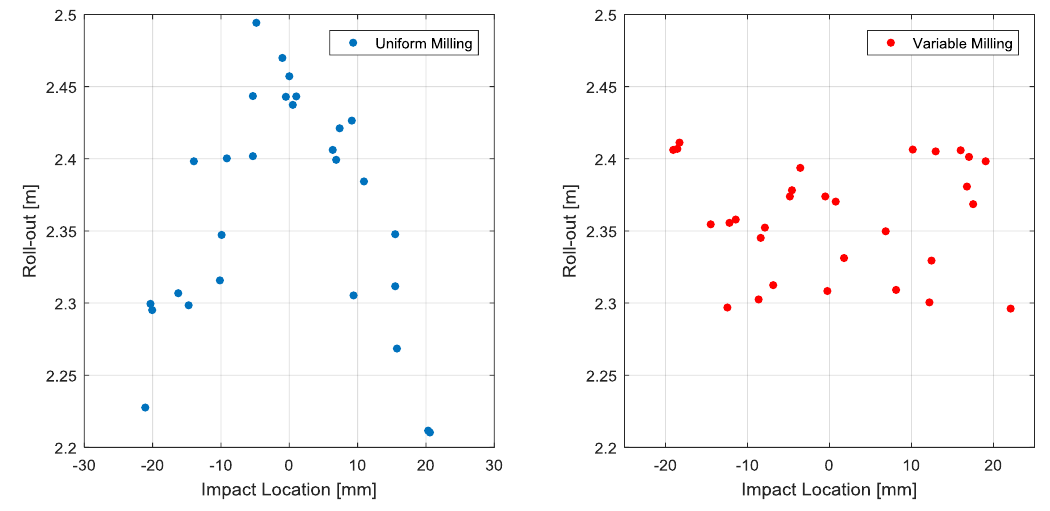
Figure 7. Roll-out testing for variable milling